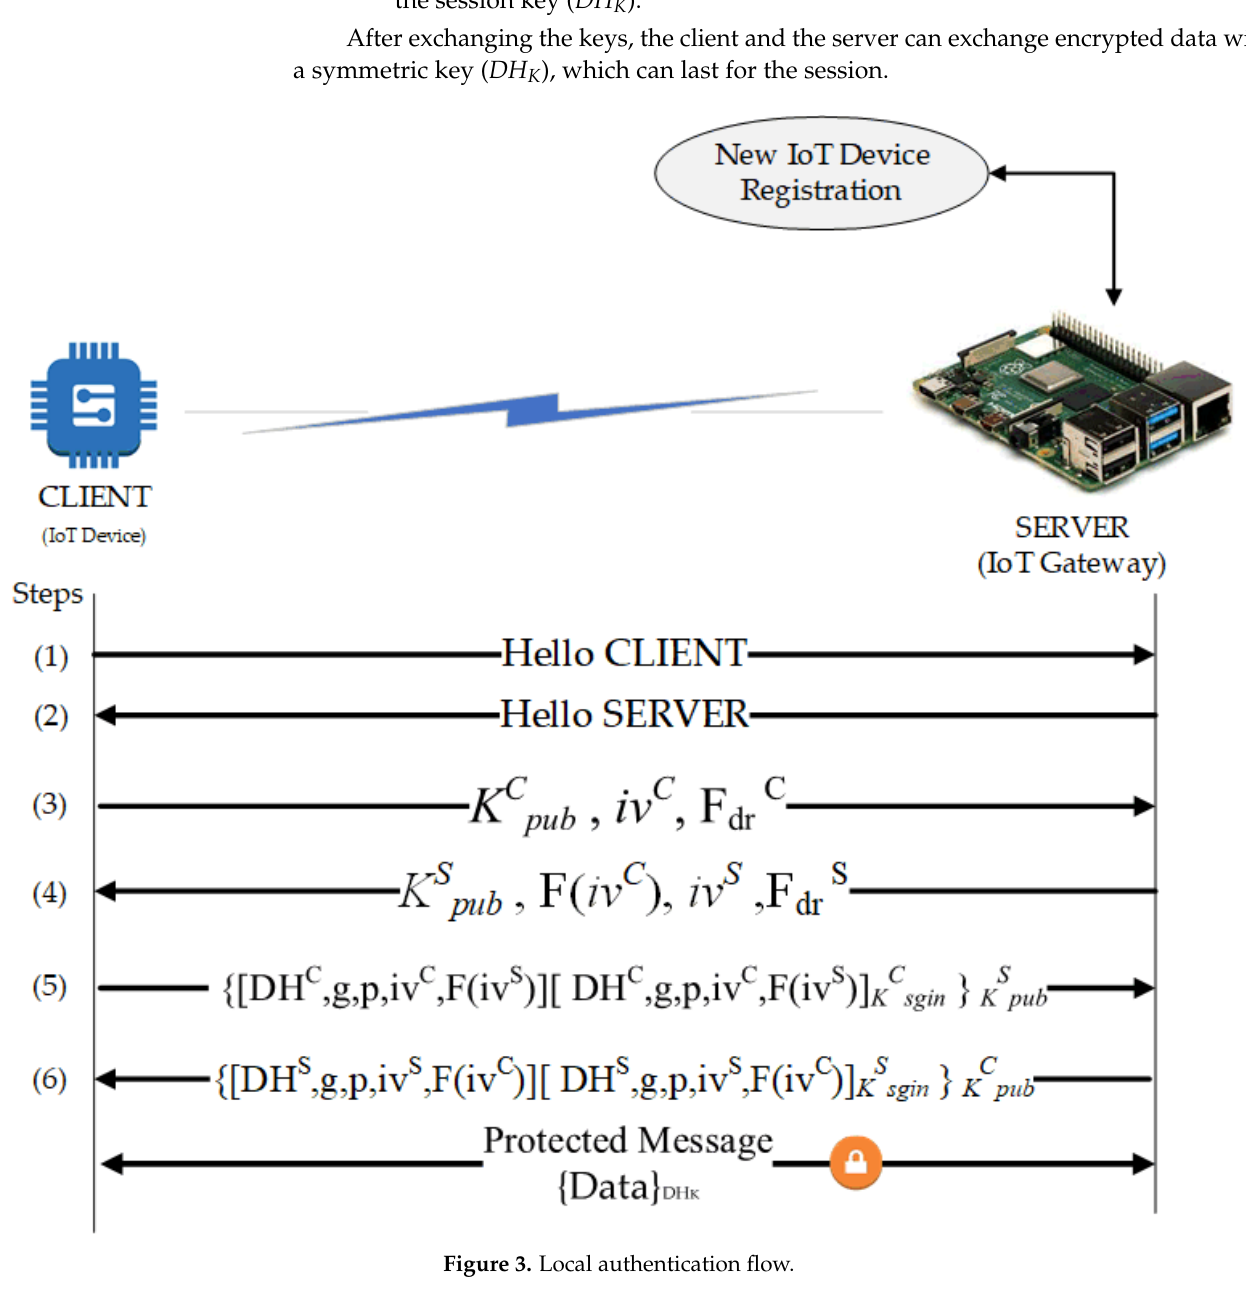
Figure 3. Local authentication